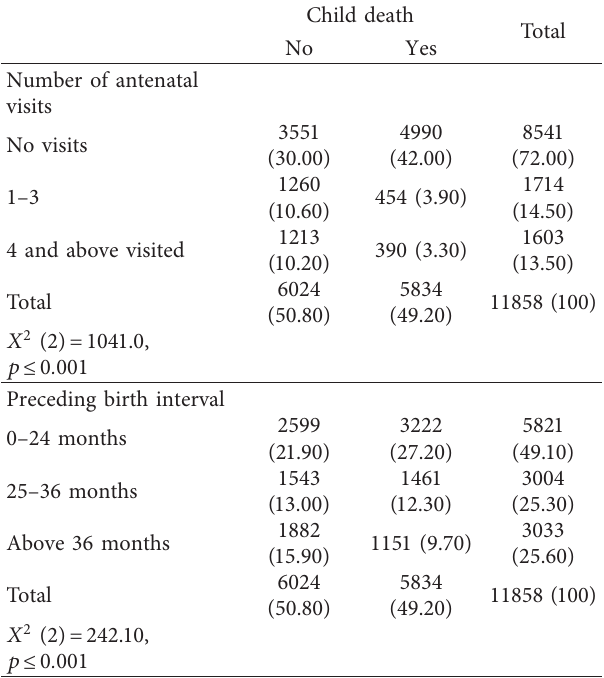
Table 16: Number of antenatal visits and preceding birth interval on child